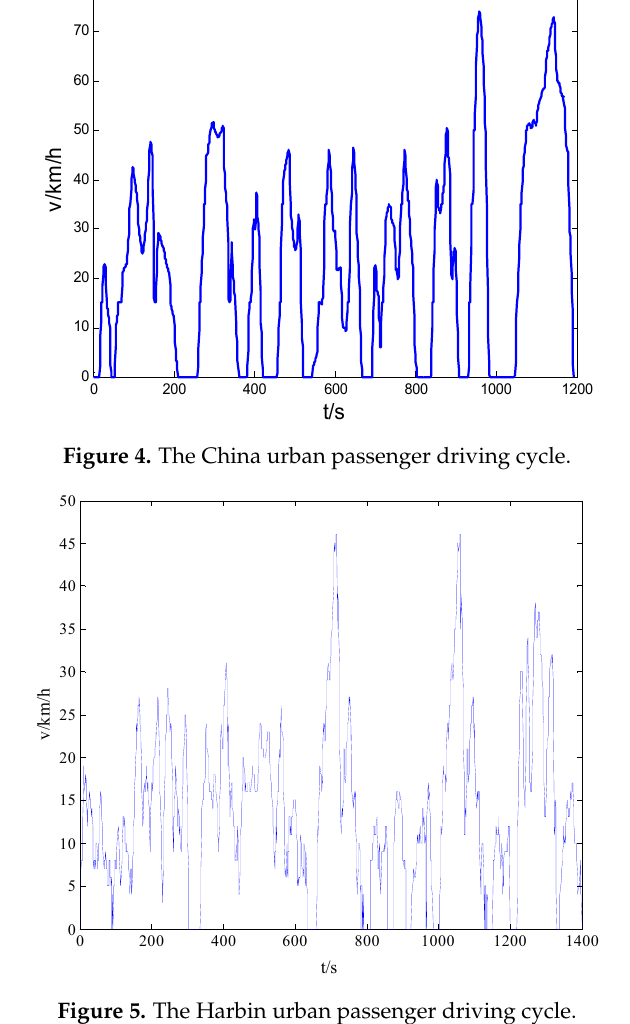
Figure 5. The Harbin urban passenger driving cycle. Table 1. Comparison of main characteristic values under two different driving cycles.